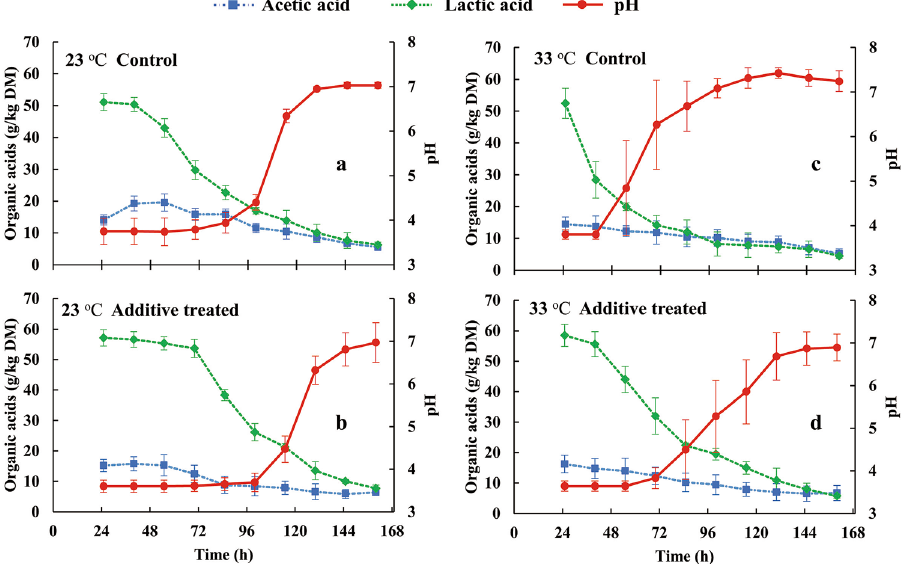
Figure 4. Acetic acid, lactic acid and pH patterns in control ( a , c ) and biological additive-treated samples ( b , d ) at 23 °C ( a , b ) or at 33 °C ( c , d ) for 168 h of